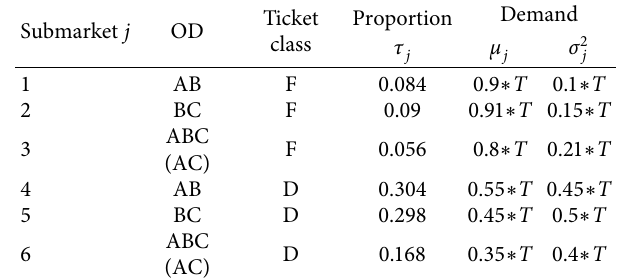
Table 5: Customer arrival